Question: In a single sentence, describe what this figure presents.
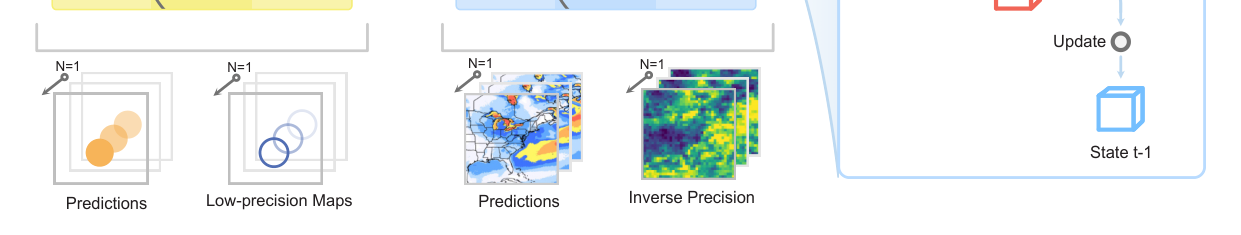
Answer: a, A general predictive coding framework. The system recognizes the sensation fields with hierarchy error units and expectation units and generates the predictions and precision maps during the process. b, Cognitive Diffusion Probabilistic Models (CogDPM) framework, providing predictions and precision weights with multi-step denoising process. c, Updates of latent states with precision- weighted predictive error.